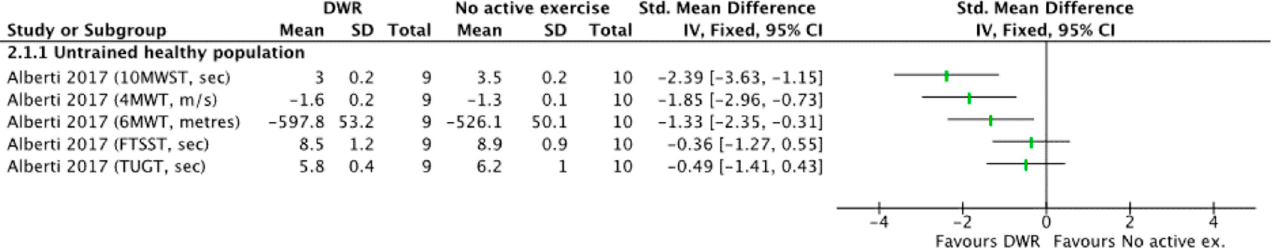
Figure 4. Standardized mean difference (95% CI) for the effect of DWR compared with no active exercise on physical function outcomes [24].